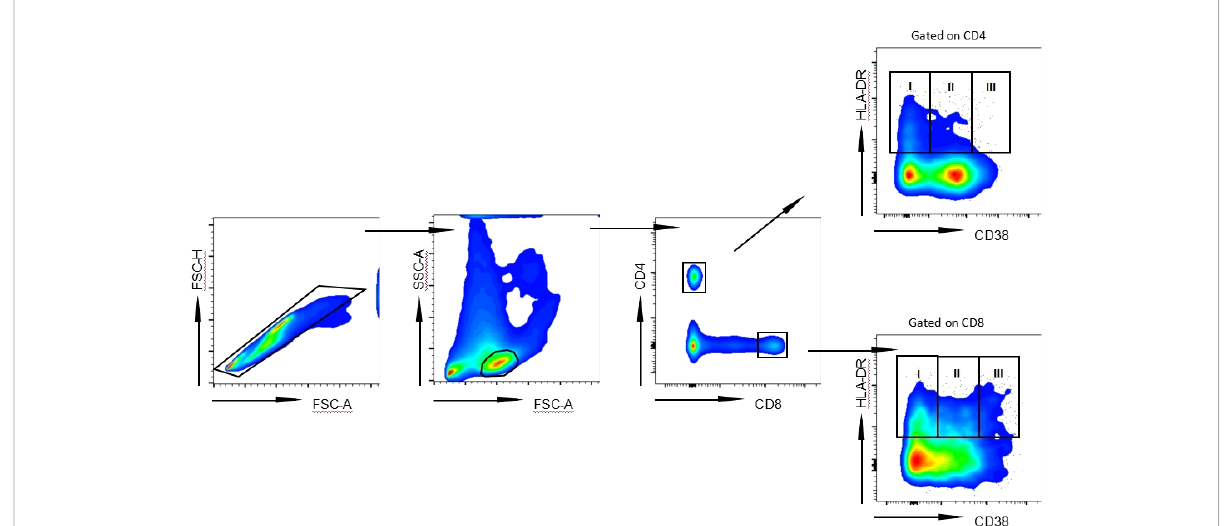
FIGURE 1 Representative fl ow cytometry gating strategy for HLA-DR + subgroups on CD4 + and CD8 + T lymphocytes. Representative FACS pseudocolor showed three subpopulations of HLA-DR + according to the expression of CD38 on CD4 + T lymphocytes and CD8 + T lymphocytes from CHB patient: HLA-DR + CD38 - (I), HLA-DR + CD38 dim (II) and HLA-DR + CD38 hi